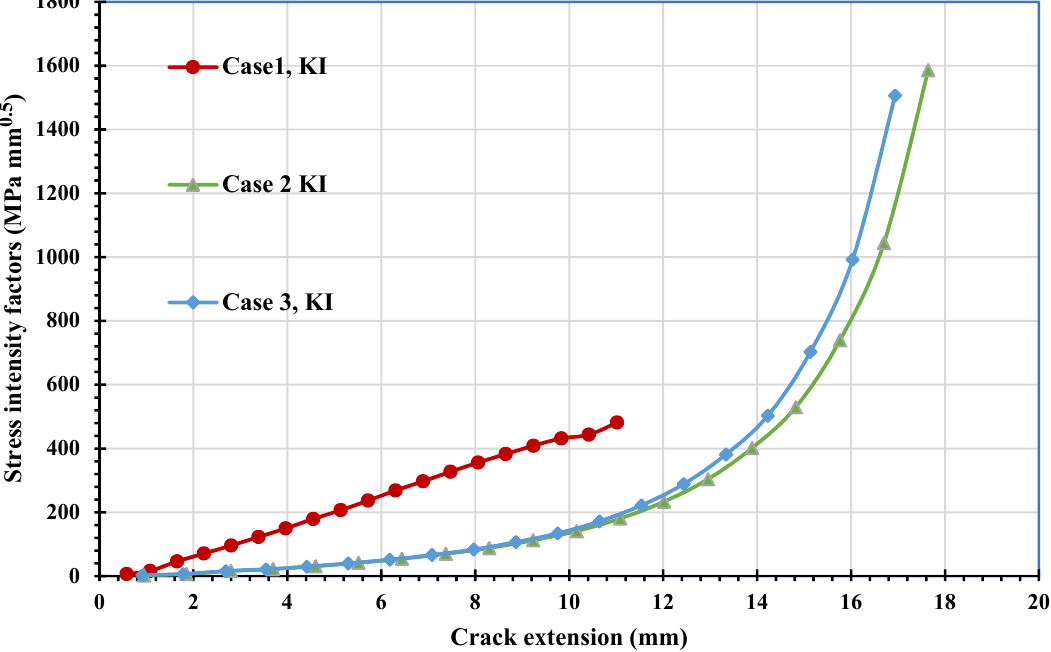
Figure 21. Predicted values of K I for the three different